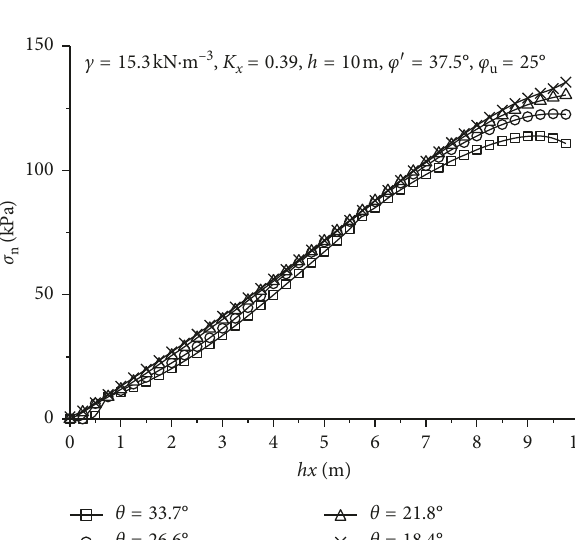
Figure 10: Distribution of membrane-slag interface shear stress.